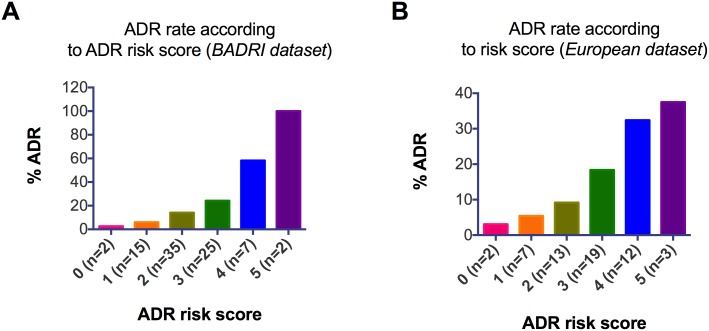
ADR rate according to ADR risk score.The BADRI risk model was applied to all 690 patients from the Brighton dataset (A), and 483 patients from the European dataset (B). The ADR rate is calculated as the proportion of patients in each scoring category that suffered an ADR. For both datasets there is a general increase in the ADR rate as the risk score increases.